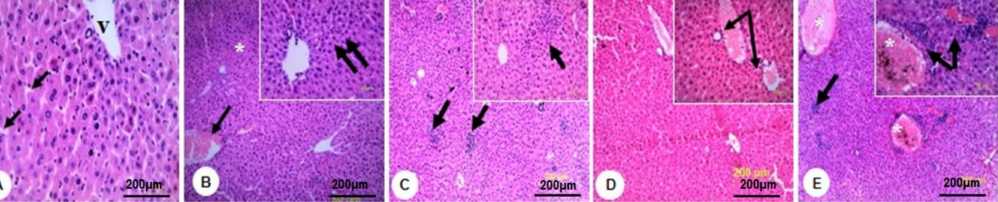
Figure 4. Photomicrographs of liver sections of rats stained with hematoxylin and eosin (H&E) (100 × , 200 × ). ( A ) Control group showing central vein (v), cords of polyhedral hepatocytes, and blood sinusoids (arrows). ( B ) MLE-treated group showing the normal lobular hepatic architecture with slight dilation and congestion of some central veins (arrows) and blood sinusoids. ( C ) Cd-treated group showing clumps of polymorphonuclear neutrophils mixed with lymphocytes infiltrates (arrow) and necrotic hepatocytes. ( D ) Cd/MLE group showing a few clumps of polymorphonuclear cells and lymphocytes infiltrates in the hepatic parenchyma (double arrows), some necrotic hepatocytes in degenerated areas (asterisks), and congestion of dilated central veins (arrow). ( E ) Cd/EDTA group showing no lobular hepatic architecture, extensive congestion of the central veins with cellular infiltration (asterisks), and small clumps of leukocytes and lymphocytic cells (arrows). Histological alterations were recorded in the renal tissues of groups treated with Cd.